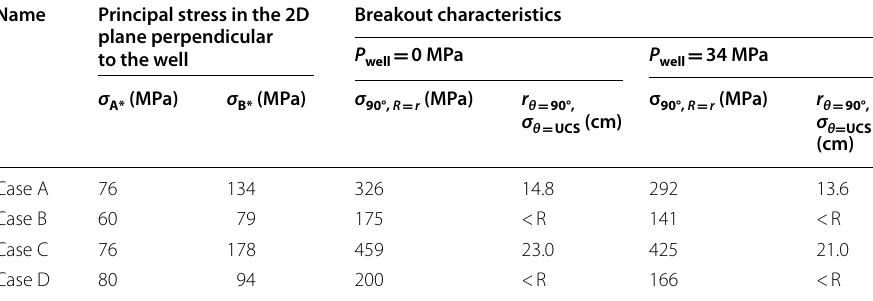
The computation of the borehole potential damage is linked to no to low wellbore fluid pressure ( P well ). σ 90° , R circumferential stress at the wellbore boundary in the direction of the minimal 2D stress, r θ from the wellbore center where the circumferential stress is equal to the UCS of the dolerite (214 MPa), in the direction of the minimal 2D stress, R is the radius of the borehole. Principal stresses in the cross section perpendicular to the well are obtained by diagonalization of the stress state ( σ ss , σ dd , τ sd ) mentioned in Table 1 and are thus slightly different